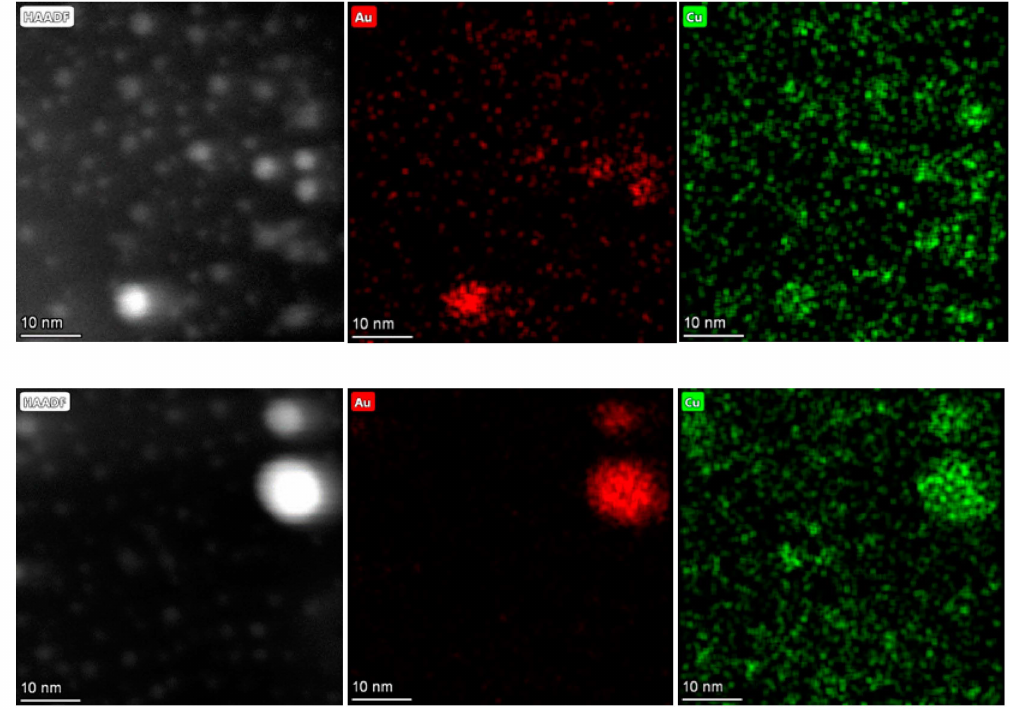
Figure 4. HAADF image with Au and Cu elemental maps (background corrected and fit Au-L and Cu-K intensities, respectively) recorded during the STEM-EDS measurement of Au 1 Cu 4